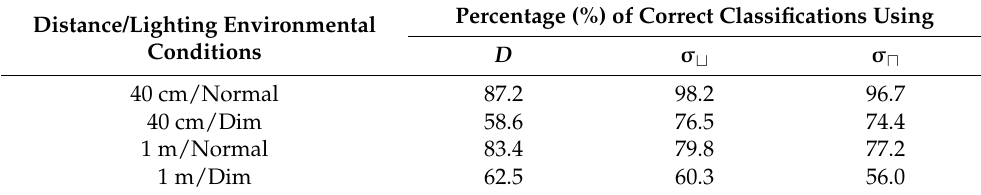
Table 3. Results by the GbCvector classifier with complement coding for four different environmental conditions.